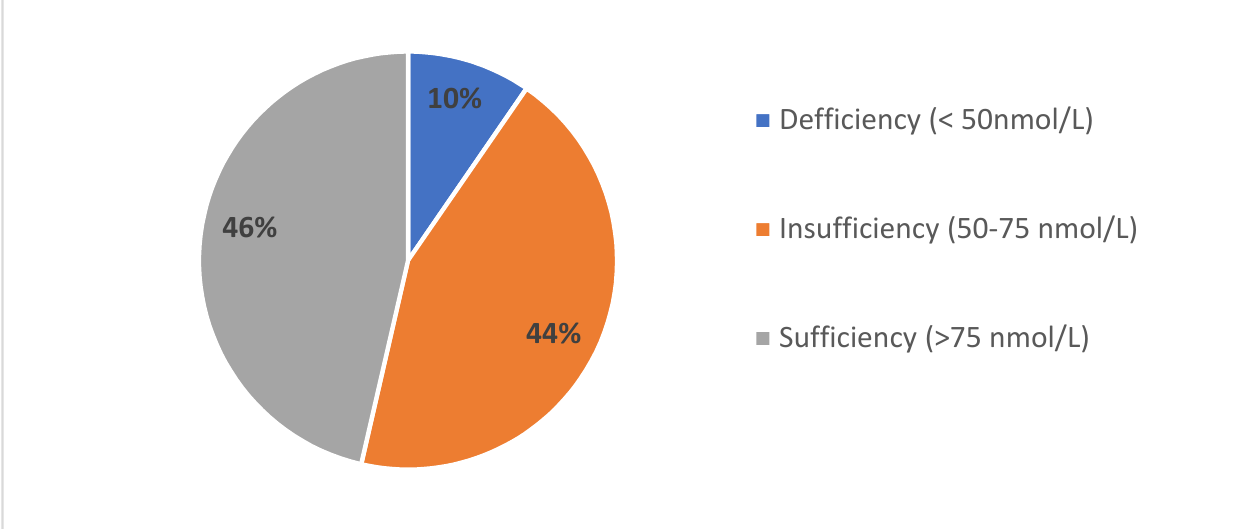
Figure 2. Vitamin D status (25(OH)D levels) in youth soccer players from southern Croatia.